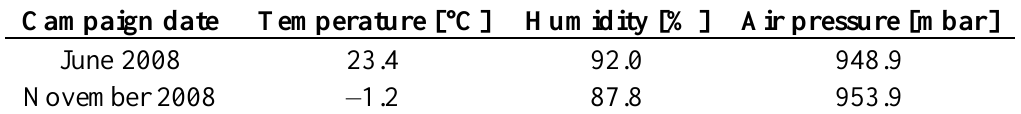
Table 1. Atmospheric parameters of the two surveying campaigns (average values). All the atmospheric parameters were measured at the site of the instrument only.